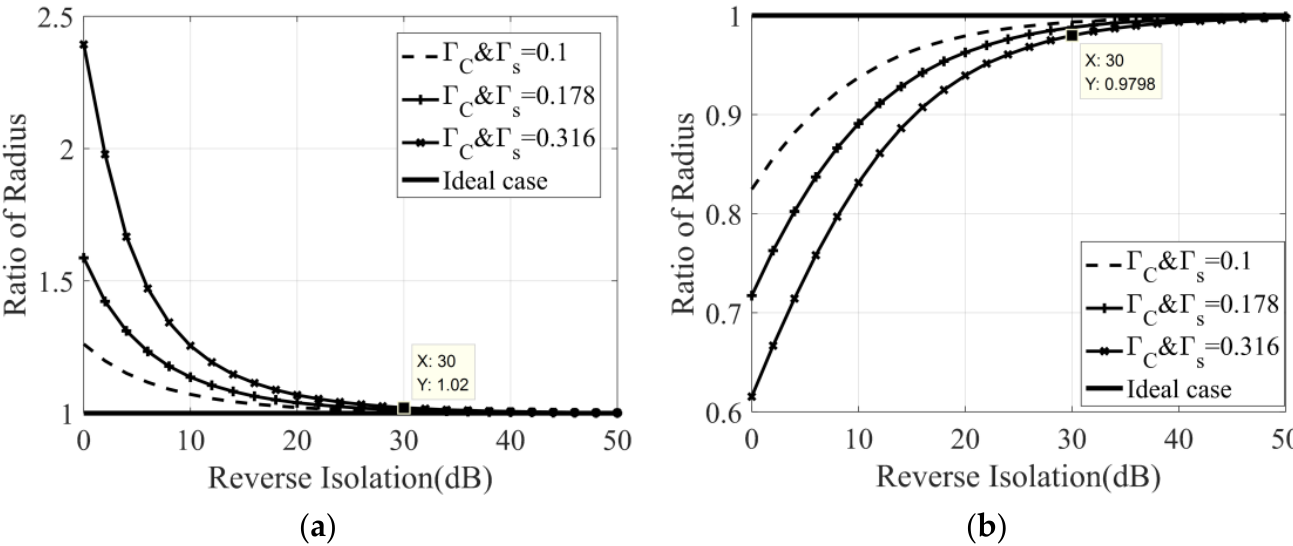
Figure 3. The variation in the correlation circle and its radius with the phase shift θ l : ( a ) correlation circle; ( b ) correlation circle radius.